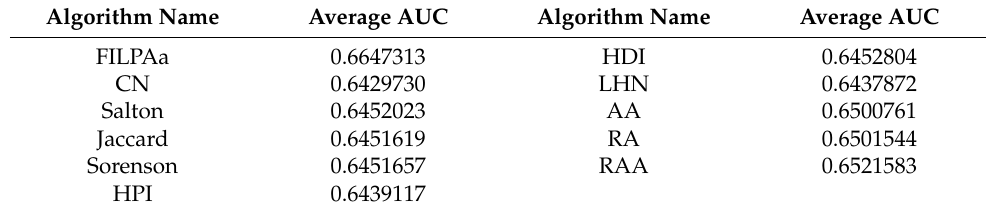
Figure 5. Performance comparison of FILPA and all reference methods.